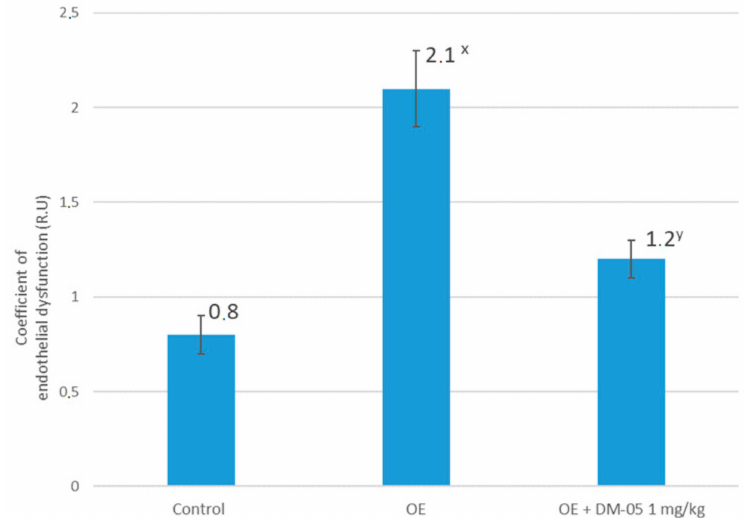
Figure 1. The values of the coe ffi cient of endothelial dysfunction (relative units, RU) in animal groups with hypoestrogen-induced endothelial dysfunction, and its correction by furostanol glycosides from Dioscorea deltoidea cell culture DM-05 ( n = 10). OE: group with bilateral ovariectomy; OE + DM-05: group with bilateral ovariectomy treated with DM-05 at a dose of 1 mg / kg; x p < 0.05 compared to the control; y p < 0.05 compared to the group with